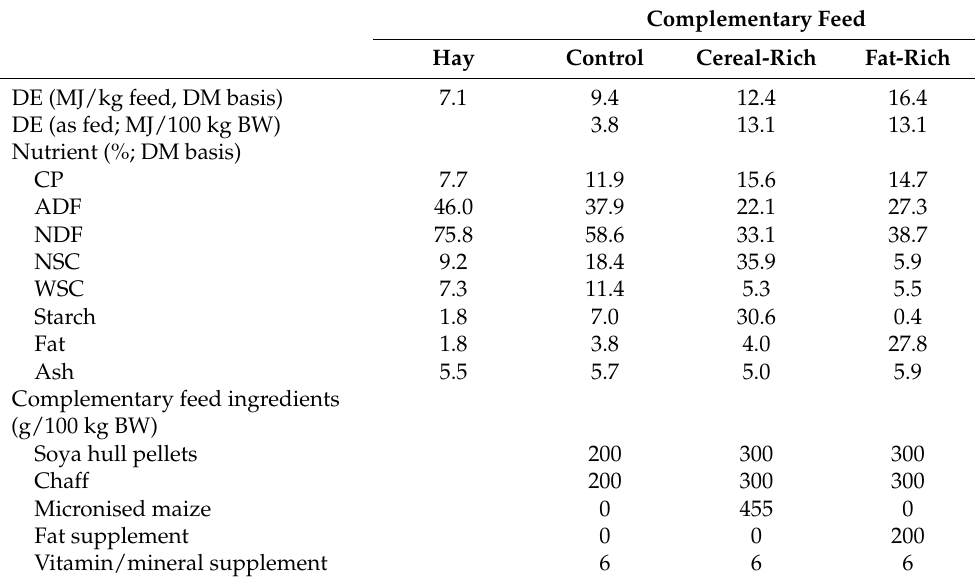
Table 1. Proximate analysis and ingredient composition of the study diets [11]. Hay was sourced from a single batch for the duration of the study and provided ad libitum. Animals were fed either control, cereal-rich or fat-rich complementary feeds divided into two daily meals. Complementary Feed Hay Control